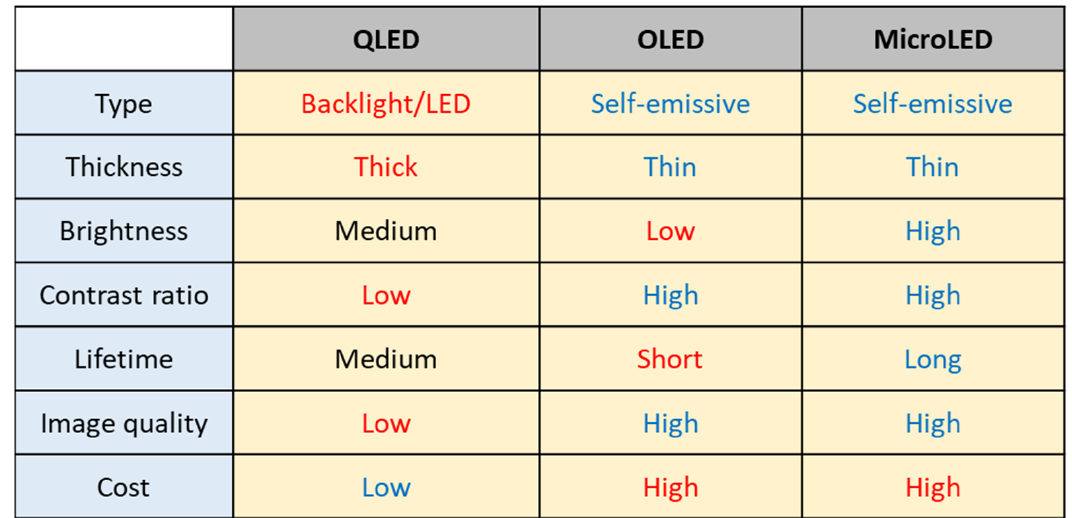
Figure 2. Comparison of QLED, OLED, and μ LED display in terms of structure, optical/electrical properties, lifetime, and cost (red: disadvantages, blue: advantages).